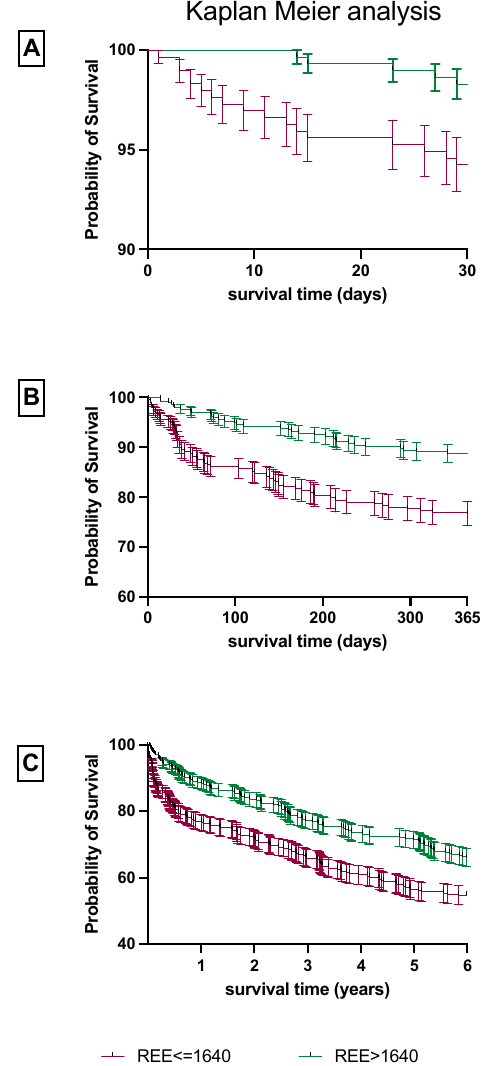
Figure 3. Kaplan–Meier analysis of patients with a high and low REE. Survival analysis was per- formed using the Kaplan–Meier for 30 days ( A ), 1 year ( B ) and 6 years ( C ). Patients were divided into 2 groups depending on their REE being either above or below the median REE of 1640 kcal/day. REE, resting energy